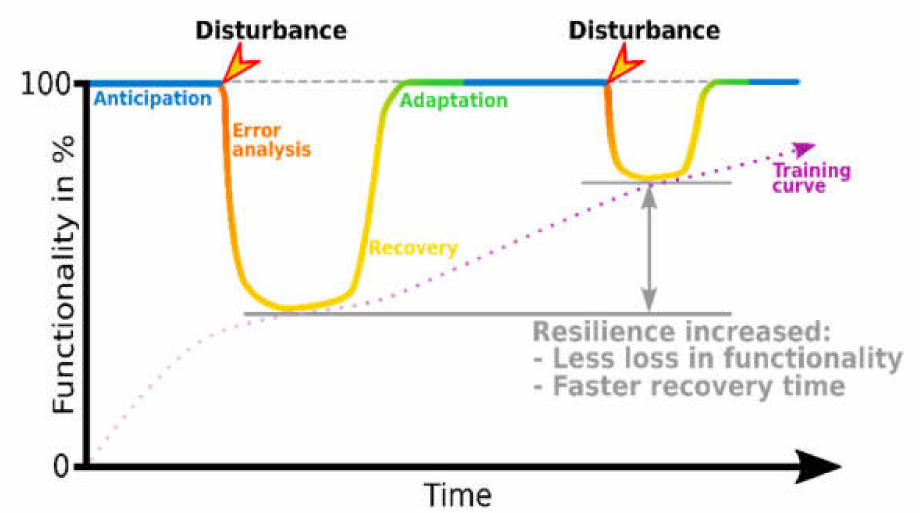
Figure 6. Schematic representation of the learning effect with the added key action error analysis. The two key actions of resistance are to be regarded as decoupled and cover the other four key actions of anticipation, error analysis, recovery and adaptation